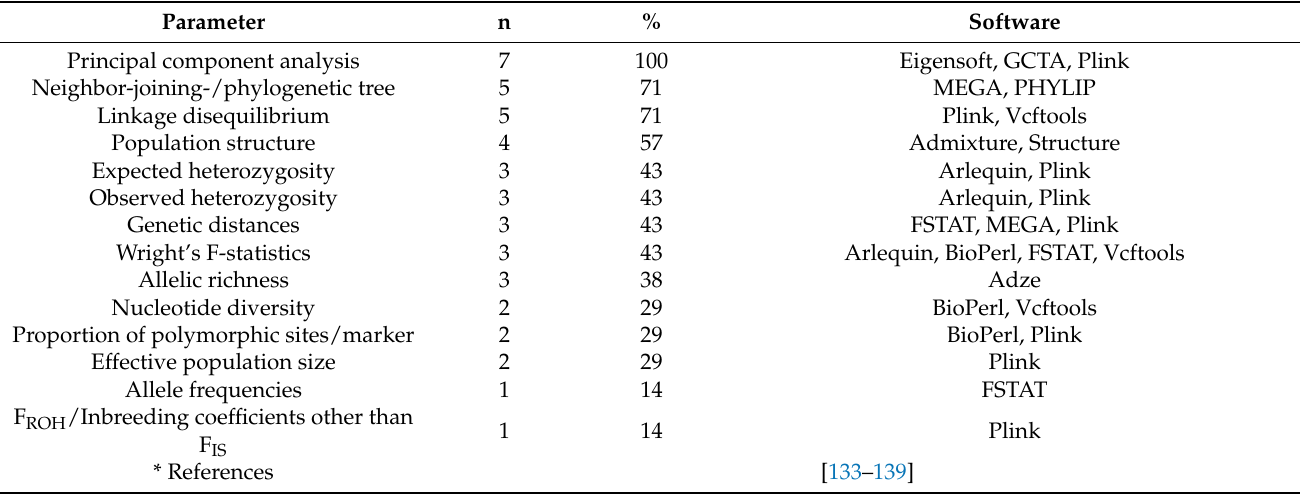
Table 4. Percentage of computed diversity parameters in seven studies * based on whole-genome sequencing and respective software programs used (for citations, see Table